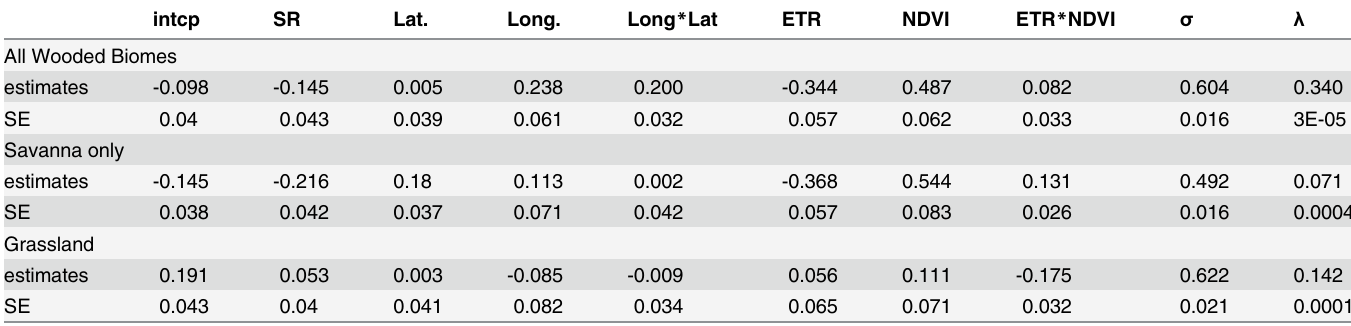
Table 2. Spatially auto-correlated regressions of taxonomic dispersion (NRI1) against species richness SR, latitude, longitude, water availability (ETR increases with water availability), and primary productivity (NDVI increases with primary productivity). σ and λ respectively estimate the remaining variance and the autocorrelation coefficient. All variables were standardized to a mean of 0 and standard deviation of 1 before analysis. intcp SR Lat. Long. Long * Lat ETR NDVI ETR *